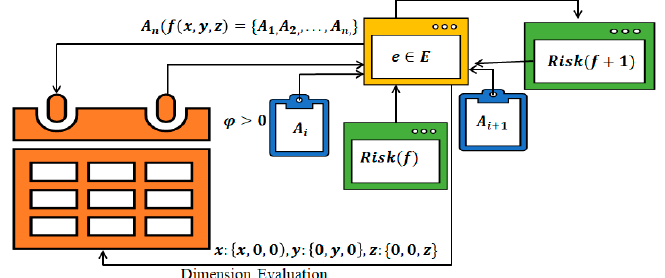
Figure 3. Illustration of maximum error bounds for risk estimation global function.